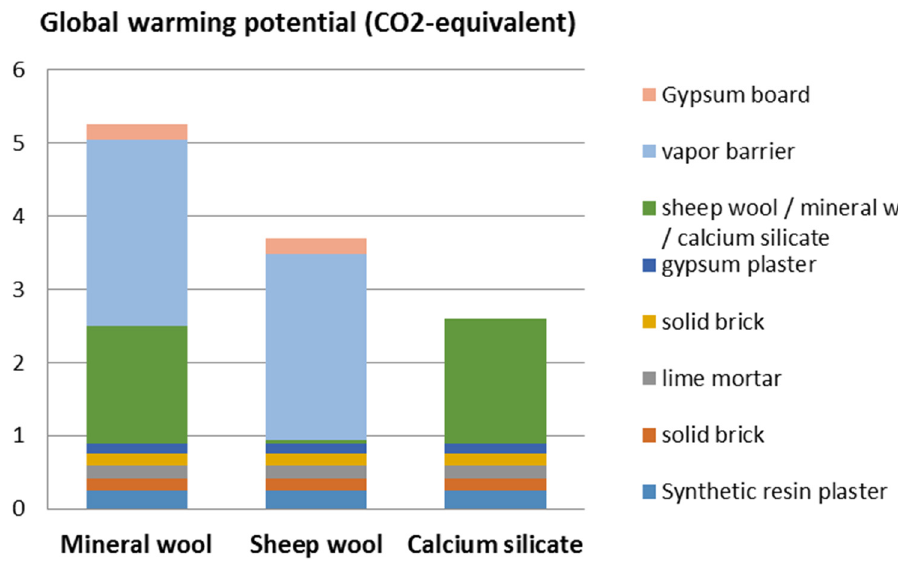
Figure 6. Global warming potential of the constructions with mineral wool, sheep wool and calcium